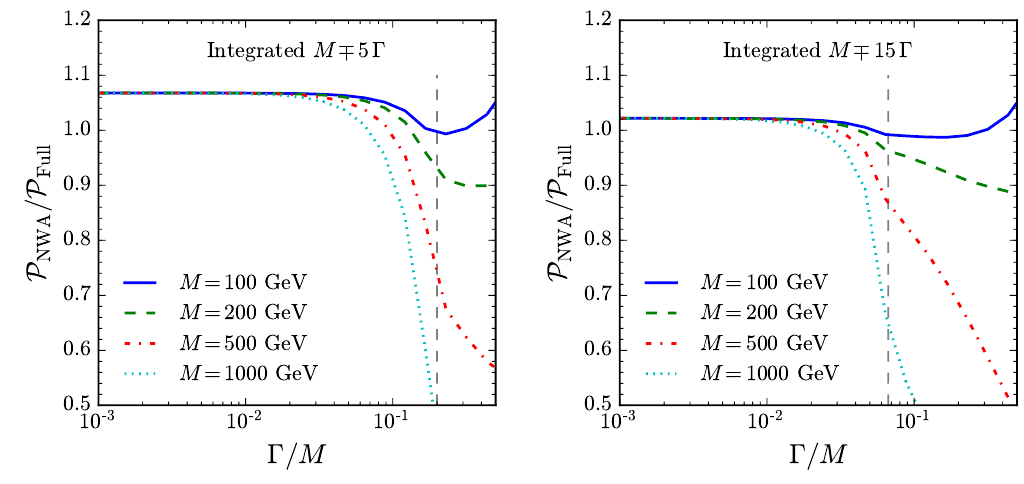
Figure 4 . This (cid:12)gure shows a comparison between integrating over a full squared matrix element or using the narrow width approximation by plotting = . The left and right panels show P NWA P Full the result when the integration limits are 5 or 15 widths around the resonance peak, respectively. The vertical dashed lines show the value of the width-to-mass ratio which would lead to unphysical imaginary momenta in the integration; values to the right use a constant lower bound for the integration instead. We see that the NWA is no longer a good approximation for (cid:0) =M & 10 (cid:0) 2 , and that this breakdown happens earlier as the mass is